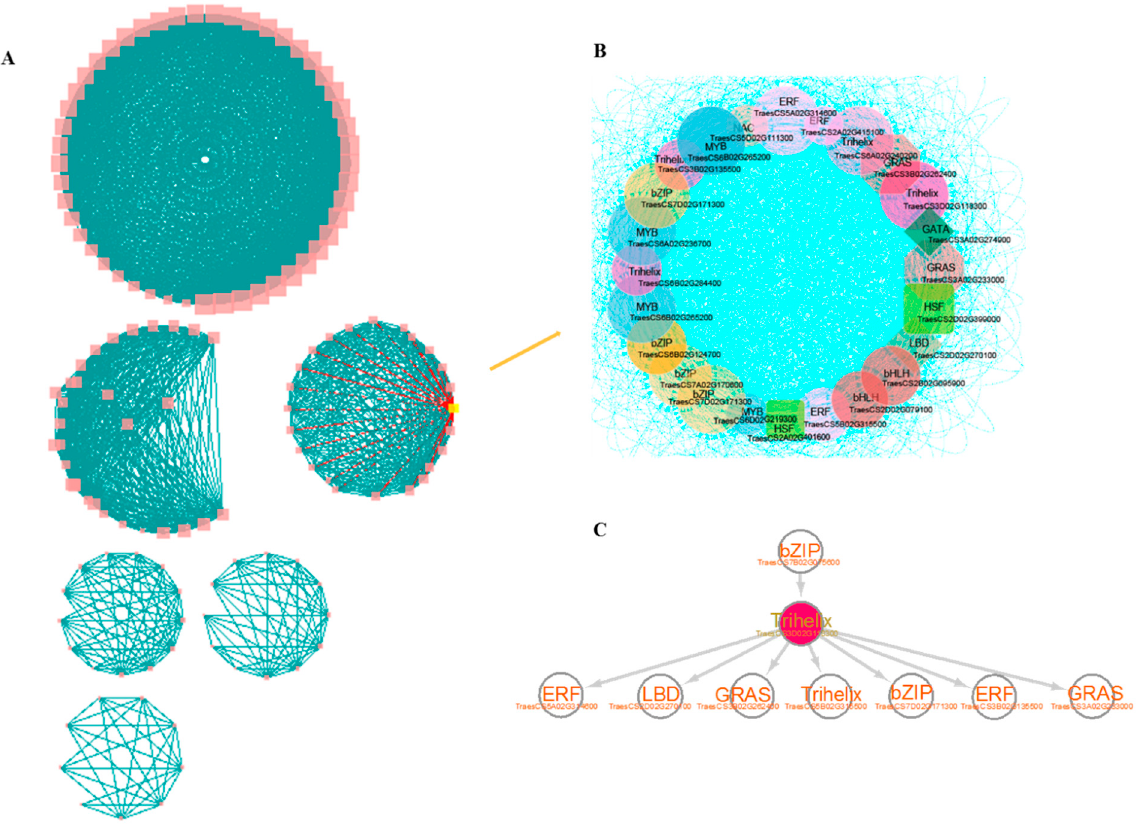
Figure 5. Construction of TF-centered regulatory networks. ( A ), Construction of TF related co-expression network using H3K4/K27me3 marked TFs. ( B ), Modules related to spikelet development were selected from the co-expression network. ( C ), A regulatory network with the regulation direction was re-constructed using GENIE3 for the TFs in the selected modules, and the top 1000 weighted regulatory relationships were selected, 9 TFs of which were present in the co-expression modules.